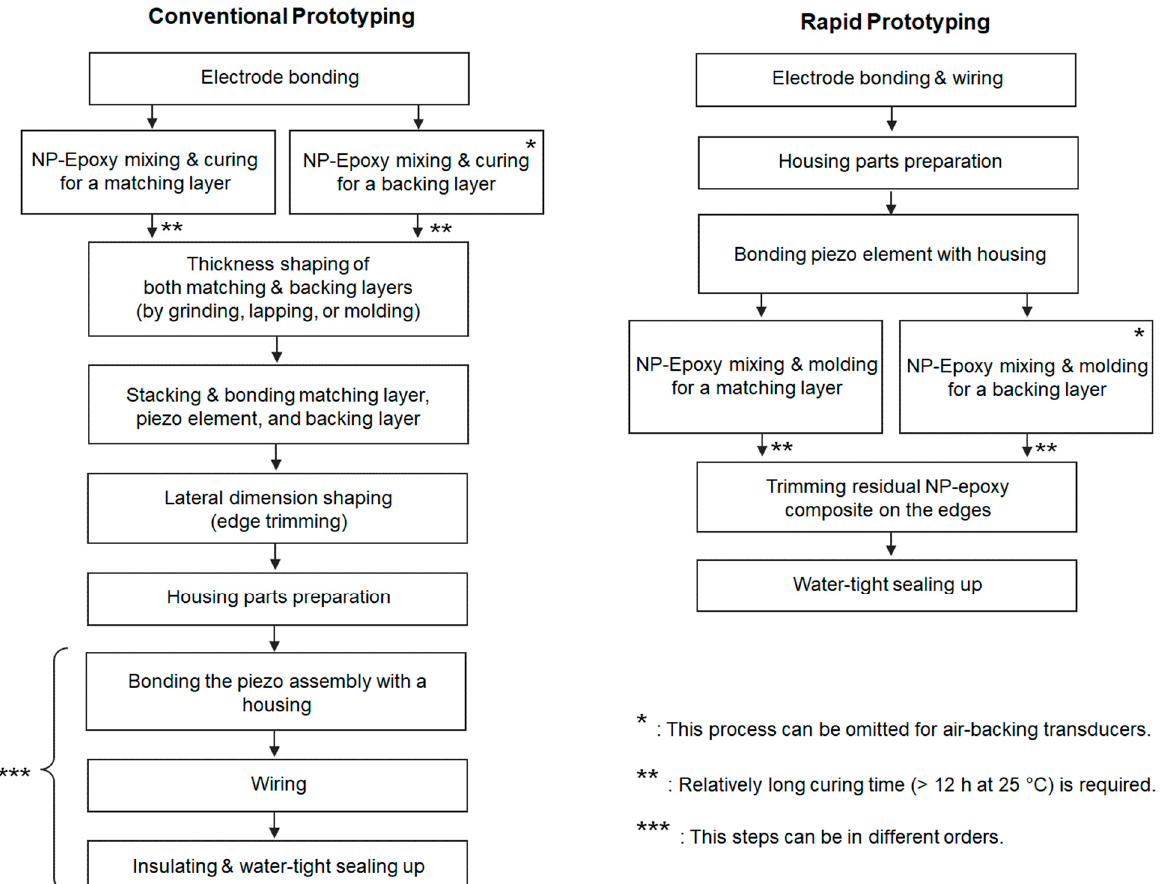
Figure 1. Prototyping flow chart; the rapid prototyping method reduces approximately two core fabrication stages compared to conventional prototyping methods. NP: nanoparticles.